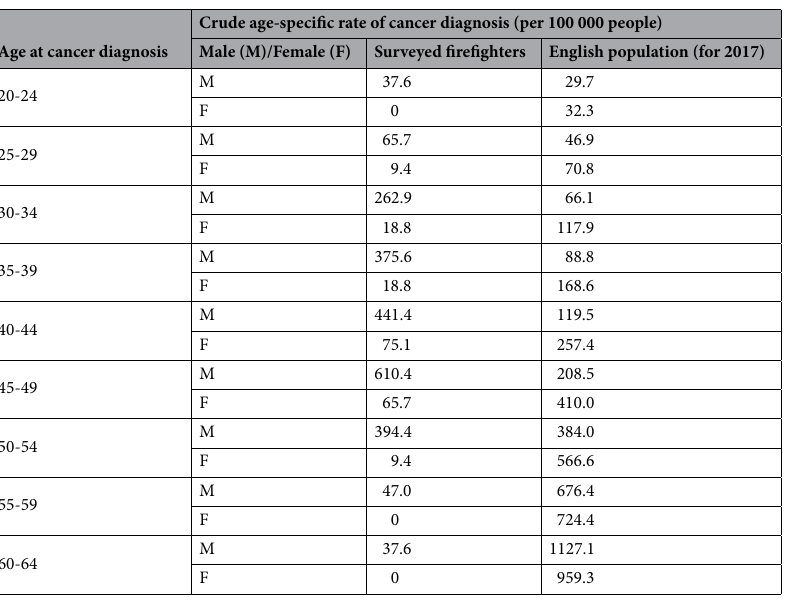
Table 1. Crude, age-specific rate (per 100, 000 people) of cancer in surveyed firefighters compared to the population of England in 2017 22